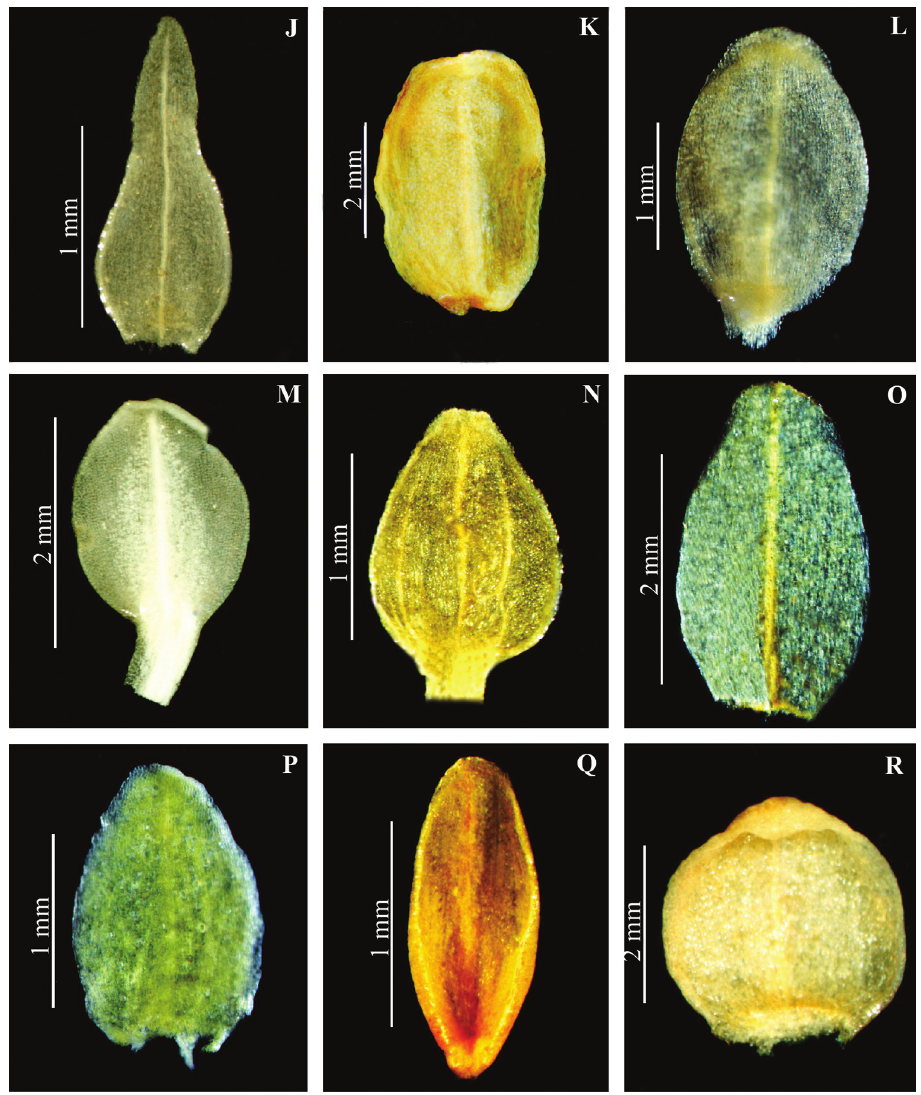
Figure 6. Continued. Dorsal sepal of Herminium. J H. fallax K H. handelii L H. elisabethae M H. hima- layanum N H. clavigerum O H. quinquelobum P H. macrophyllum Q H. mannii R H. biporosum.